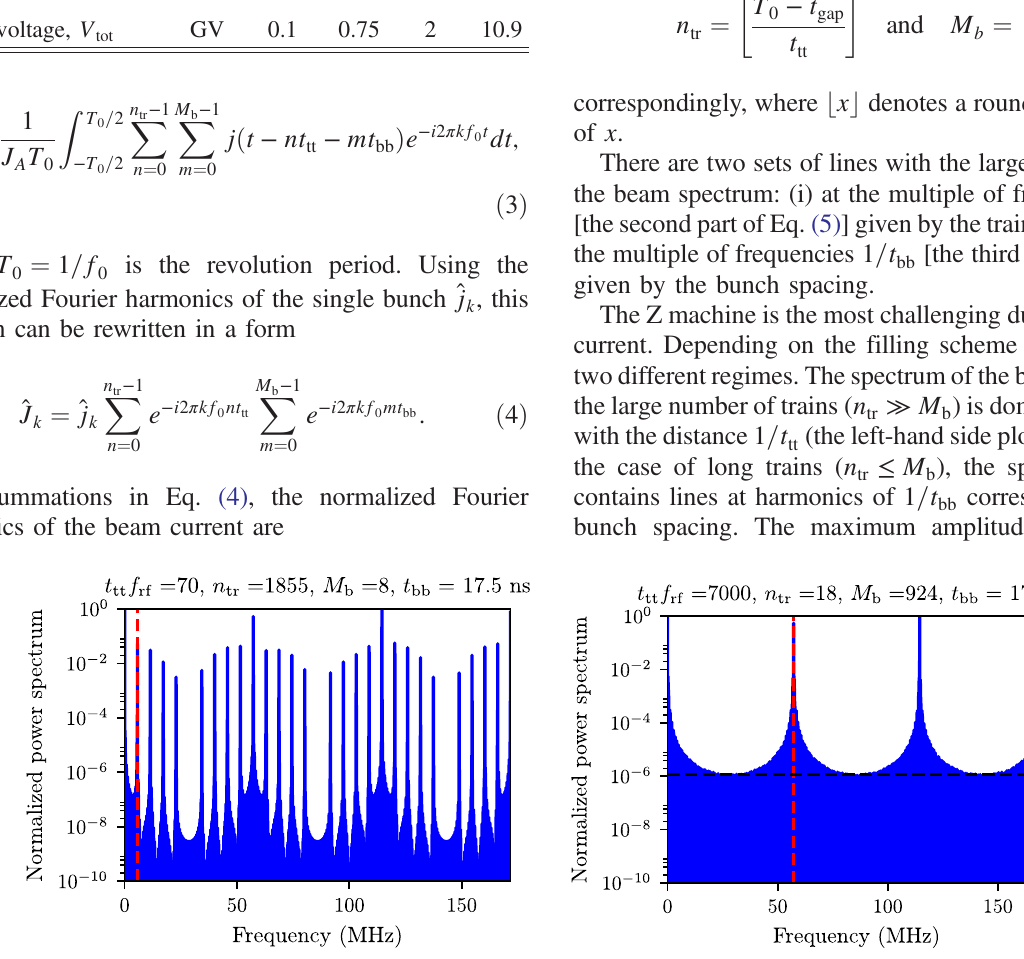
FIG. 1. Examples of the normalized beam spectra (parameters of the Z machine) for two regimes. The left-hand side plot is for the case of the large number of short trains. The red line is at 1 =t the horizontal black line is 1 =M 2